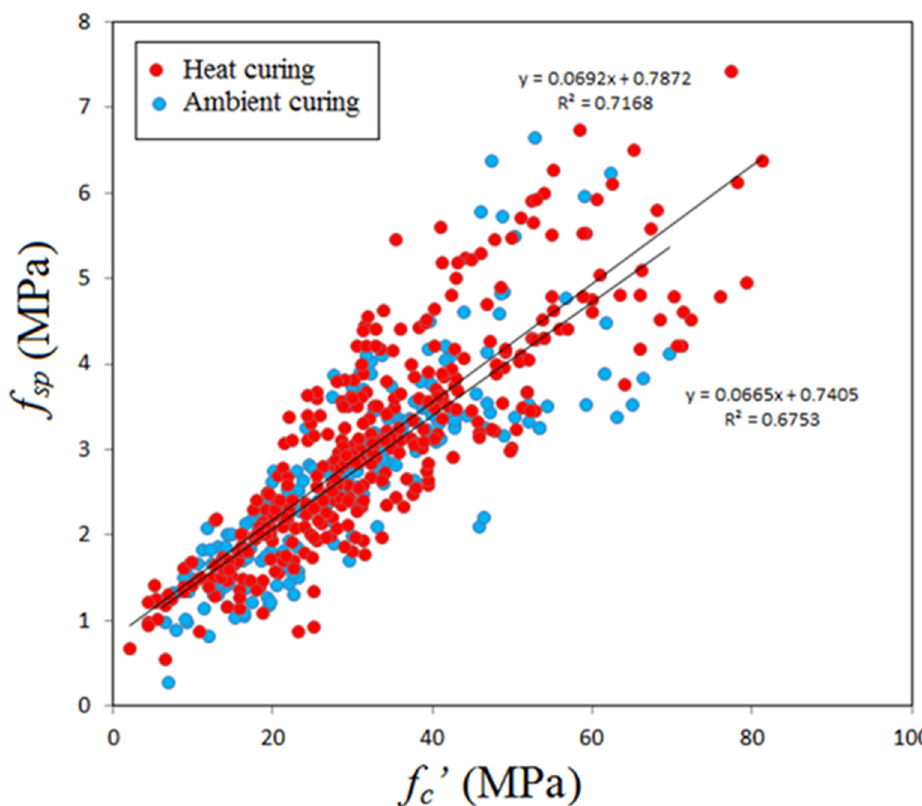
Figure 6. Variation of splitting tensile strength with compressive strength.